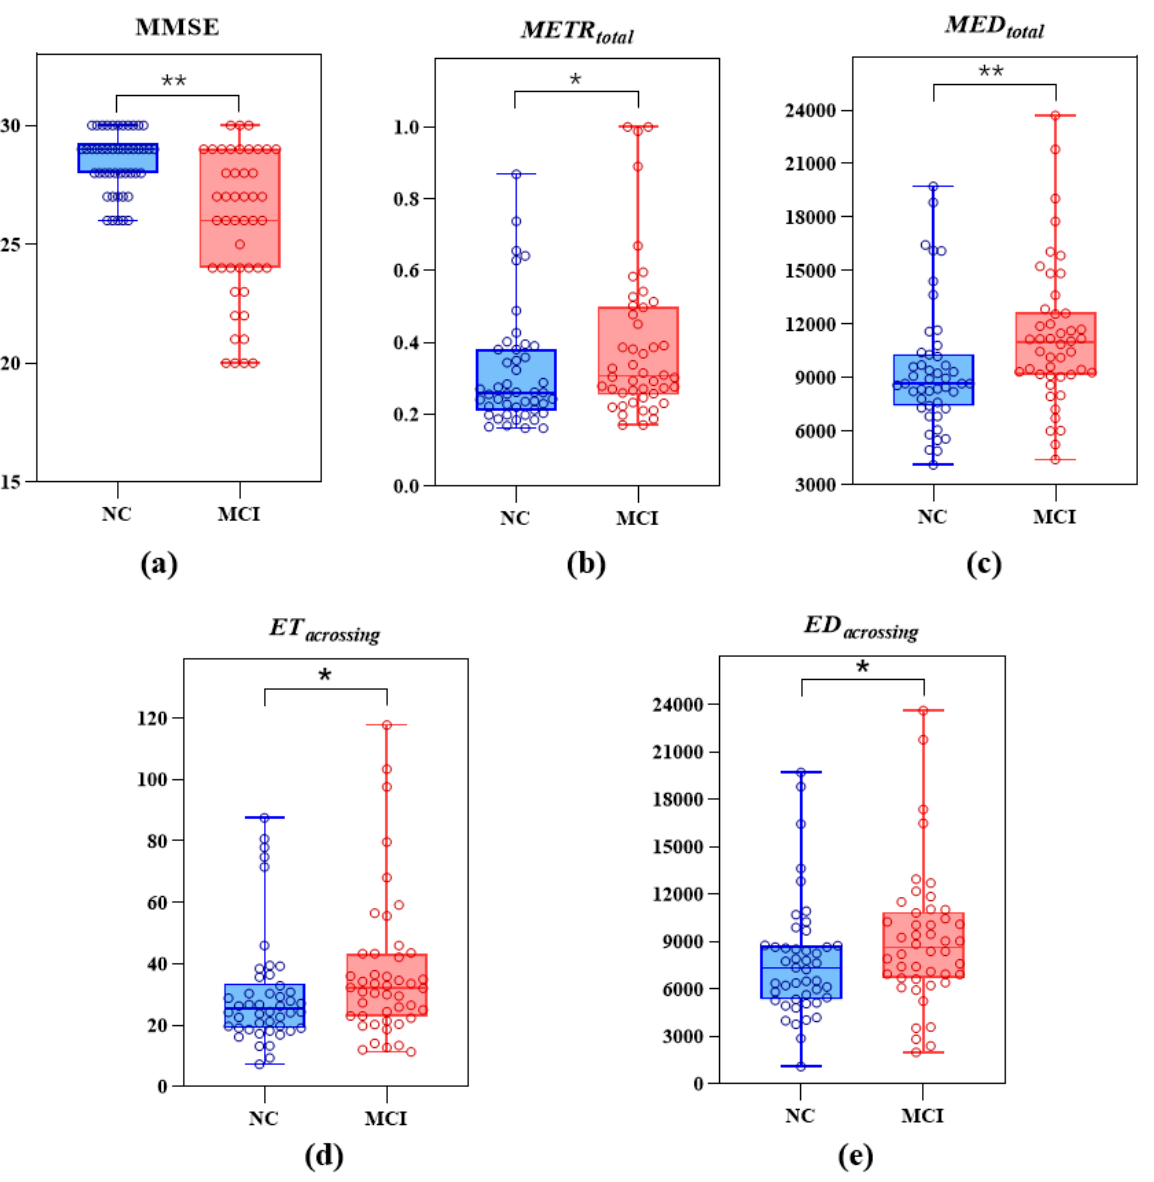
Figure 4. Distribution of ( a ) MMSE data of the NC and MCI groups, ( b ) METR total values of the NC and MCI groups, ( c ) MED total values of the NC and MCI groups, ( d ) ET crossing values of the NC and MCI groups, ( e ) ED crossing values of the NC and MCI groups (* indicates a significant difference between the two groups, at p < 0.05; ** indicates a significant difference between the two groups, at p < 0.01).